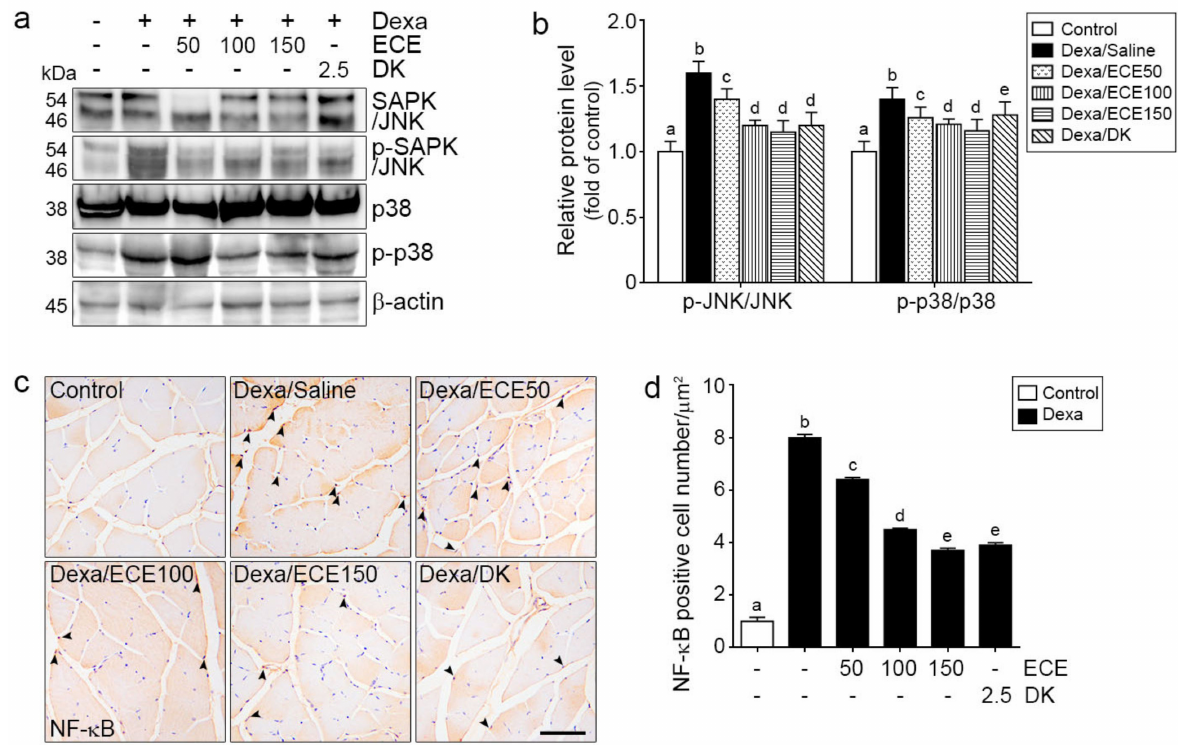
Figure 2. Inhibitory effects of ECE and DK on NF- κ B activation in the gastrocnemius muscle of the Dexa-induced muscle atrophy model. ( a , b ) Protein levels of NF- κ B activation-related molecules (SAPK/JNK and p38) were determined by Western blotting. As a result, the ratios of p-SAPK/JNK to JNK and p-p38 to p38 were increased by Dexa but decreased by ECE and DK treatment. ( c , d ) The amount of NF- κ B translocated into the nucleus was increased by Dexa but decreased by ECE and DK treatment. The dose unit of ECE and DK is mg/kg/day. a–e: Different letters indicate significant differences among groups, as determined by multiple comparison (Mann–Whitney U test); p < 0.05. Dexa, dexamethasone; DK, dieckol; ECE, Ecklonia cava extract; NF- κ B, nuclear factor kappa-light-chain-enhancer of activated B cells; SAPK/JNK, stress-activated protein kinase/Jun-amino-terminal kinase; p-SAPK/JNK, phospho-SAPK/JNK; p-p38,